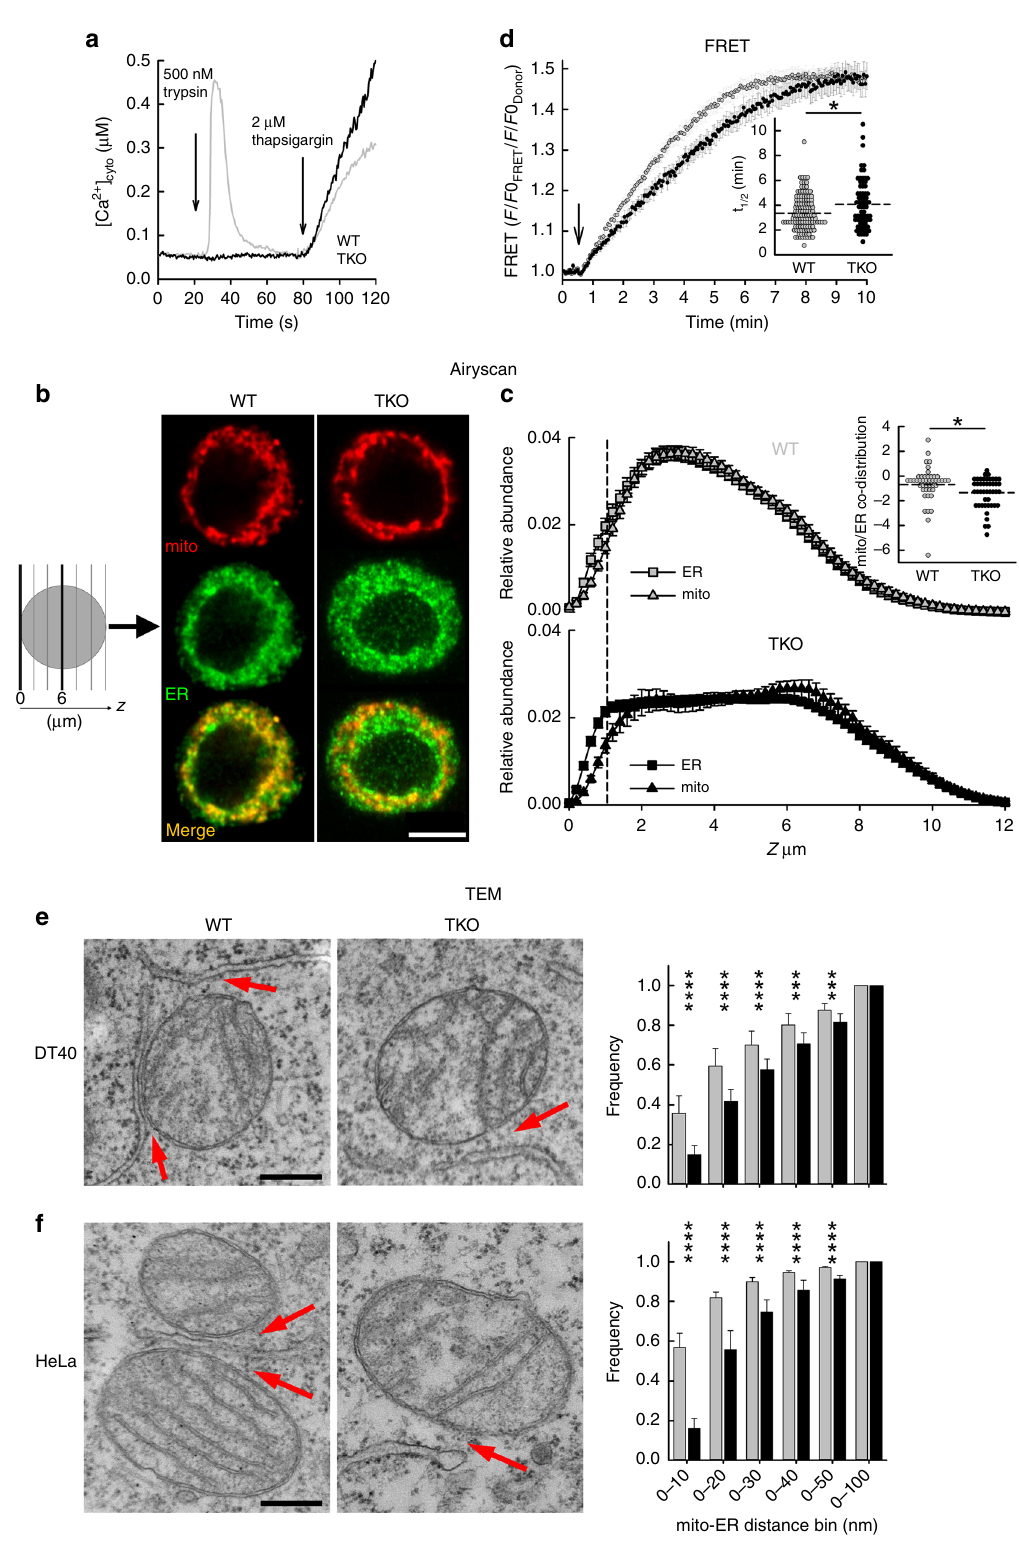
Mammalian IP3R isoforms are functional in DT40 TKO cells . To verify the function of each IP3R isoform, we used DT40 TKO cells rescued with an individual FLAG-tagged mammalian IP3R isoform. Comparing the rescue levels to the endogenous IP3R isoform abundance is dif fi cult because the anti-IP3R antibodies likely recognize avian (endogenous) and mammalian (rescue)